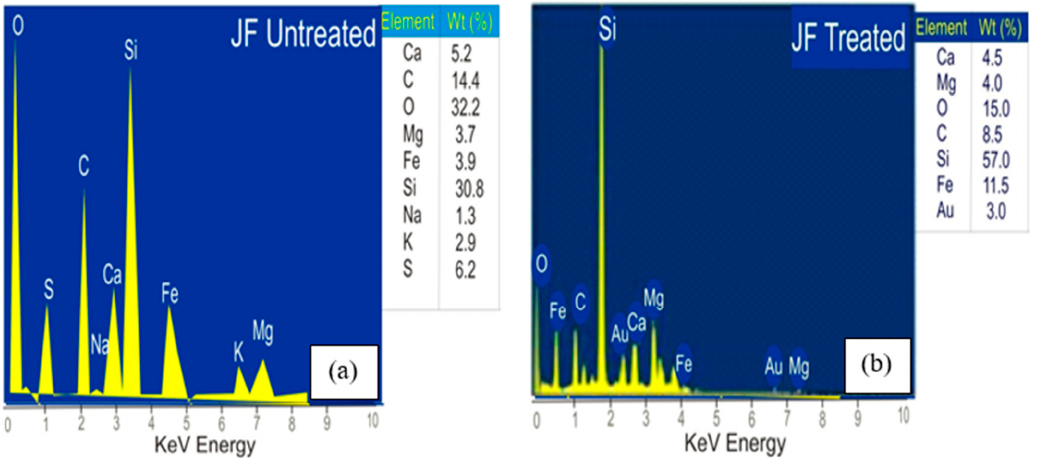
Figure 1. Elemental Composition of ( a ) Untreated Jute Fiber and ( b ) Treated Jute Fiber.